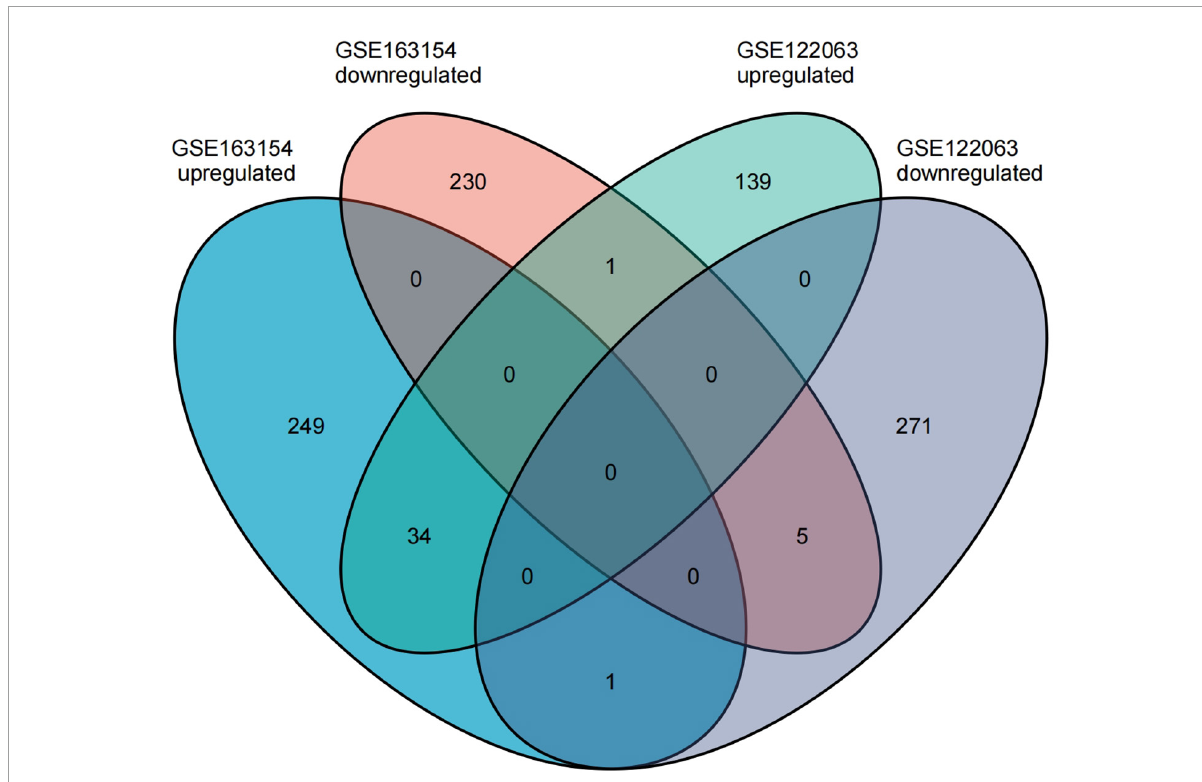
FIGURE2 The common differentially expressed genes (DEGs) were identified between the two datasets.